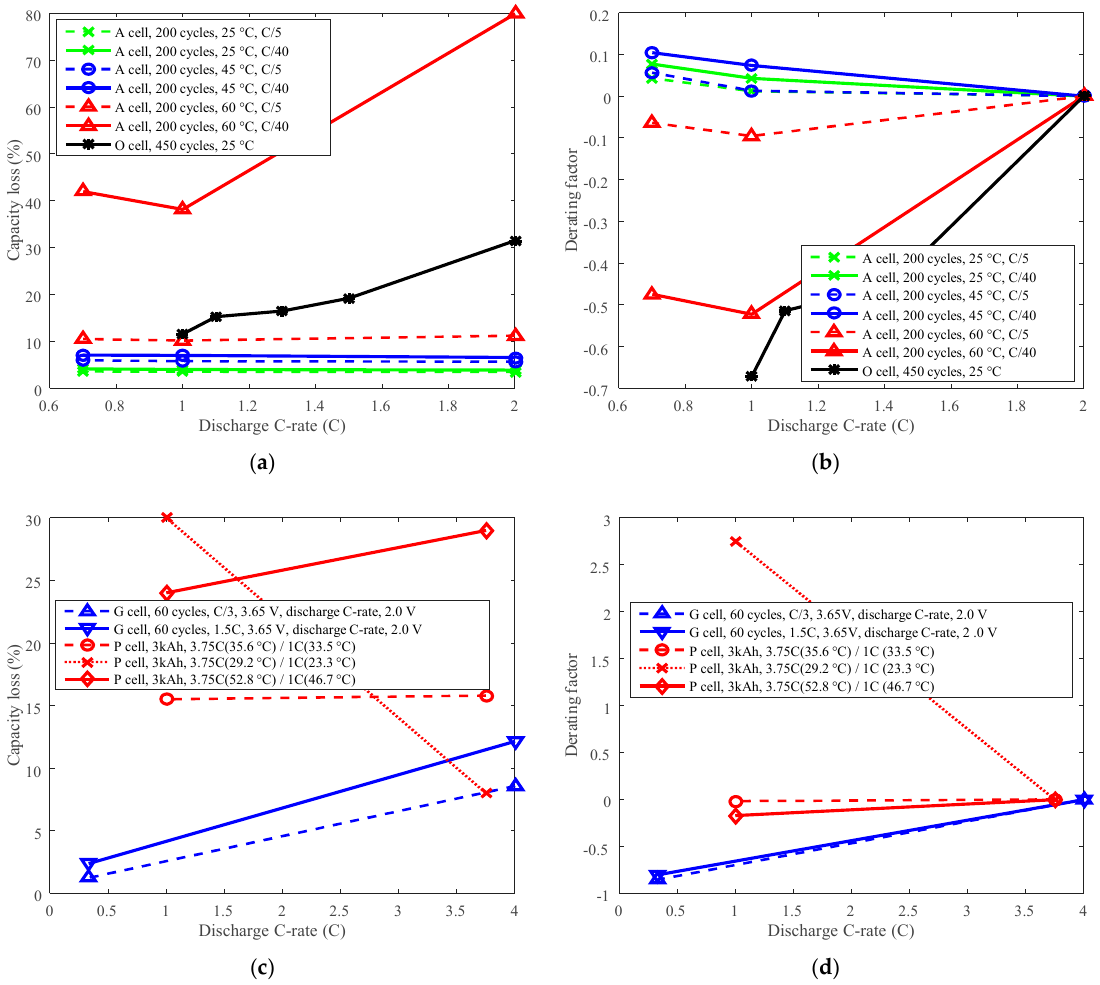
Figure 8. Derating of discharge C-rate. (a) and (c) are for capacity loss vs. discharge C-rate, (b) and (d) are for derating factor vs. discharge C-rate. (a) “A cell, 200 cycles, 25 °C, C/5” refers to the capacity loss of battery A at 200 cycles under 25 °C and charge cut-off current C/5. (c) “G cell, 60 cycles, C/3, 3.65 V, discharge C-rate, 2.0 V” means the capacity loss of battery G at 60 cycles, the battery charged at constant current C/3 to 3.65 V, and discharged to 2.0 V. “P cell, 3 kAh, 3.75C (35.6 °C)/1C (33.5 °C)” refers to the capacity loss of battery P at capacity throughput 3 kAh, the battery discharged at 3.75C under 35.6 °C, and discharged at 1C under 33.5 °C.